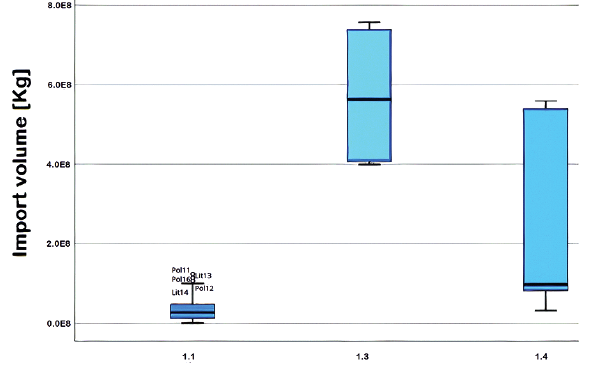
Figure 13. Post-crisis box diagram of import variable according to the clusters of the second two-stage clustering level (source: own elaboration)